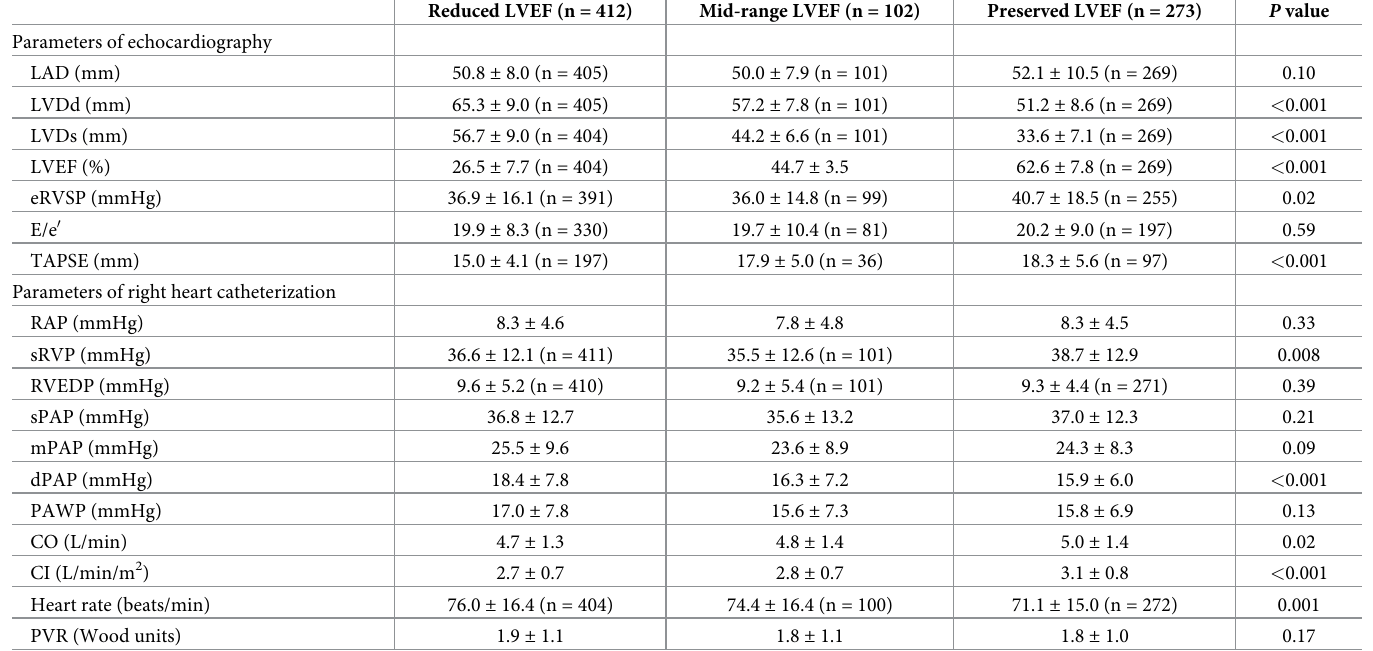
Table 3. Parameters of echocardiography and right heart catheterization of the groups stratified by LVEF.